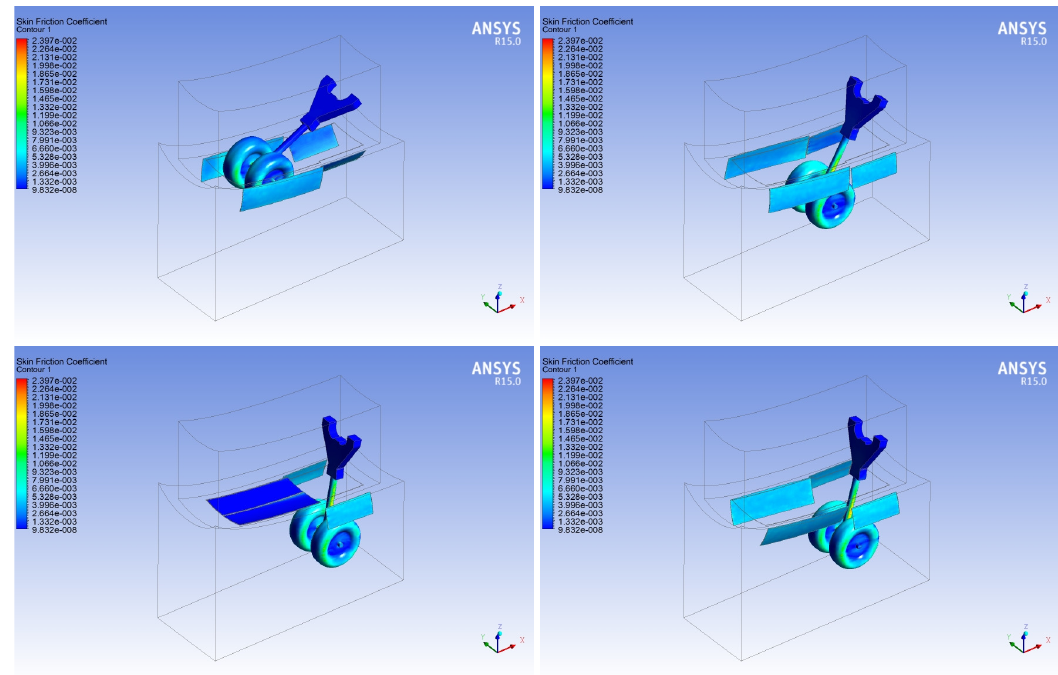
Figure 10. NLG: skin friction distribution during the lowering phase (clockwise), for the case NLG–I.